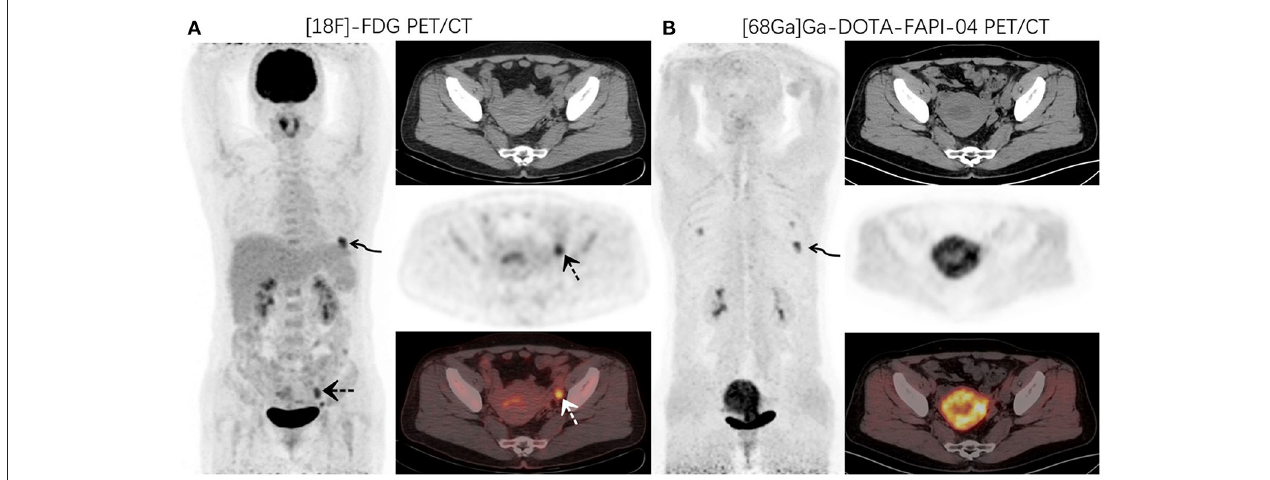
FIGURE 2 | PET/CT was performed for restaging in a 52-year-old woman who underwent thyroidectomy for thyroid cancer 1 year prior. 18 F-FDG PET/CT (A) images showed increased FDG uptake in the thyroidectomy area (curved arrow, SUVmax7.4) and left adnexal region (dotted arrow, SUVmax7.0). 68 Ga-DOTA-FAPI-04 PET/CT (B) images demonstrated increased uptake of imaging agents in the thyroid area (curved arrow, SUVmax8.9), but no abnormal uptake was observed in the left adnexal region.